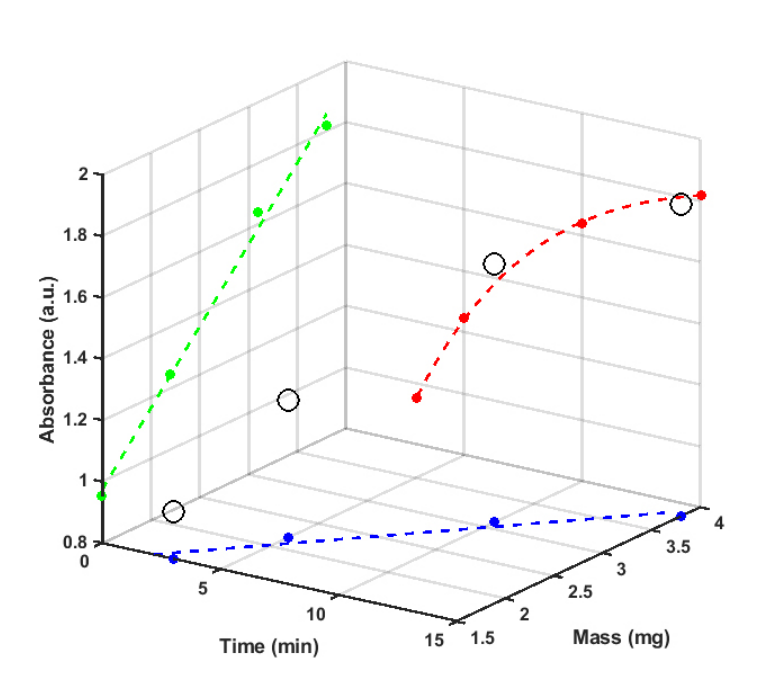
Figure 2. 3D plot of the optical absorbance value of the 226 nm peak as a function of ablation time (red data projection) and the amount, expressed in milligrams, of the ablated graphite target (green data projection) in a water volume of 10 mL (which is proportional to the amount of LCC content in the colloidal